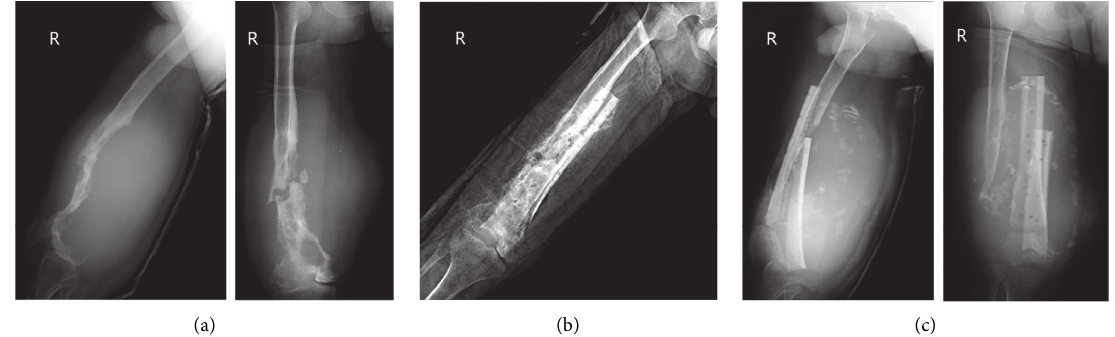
Figure 2: X-ray photography on the right femur of Patient 2. (a) The recurrent hemophilia pseudotumor before the second procedure (internal fixation with an allogeneic bone graft). (b) The postoperative situation of fracture fixation. (c) The collapse of internal fixation and recurrent pseudotumor two years after internal fixation.